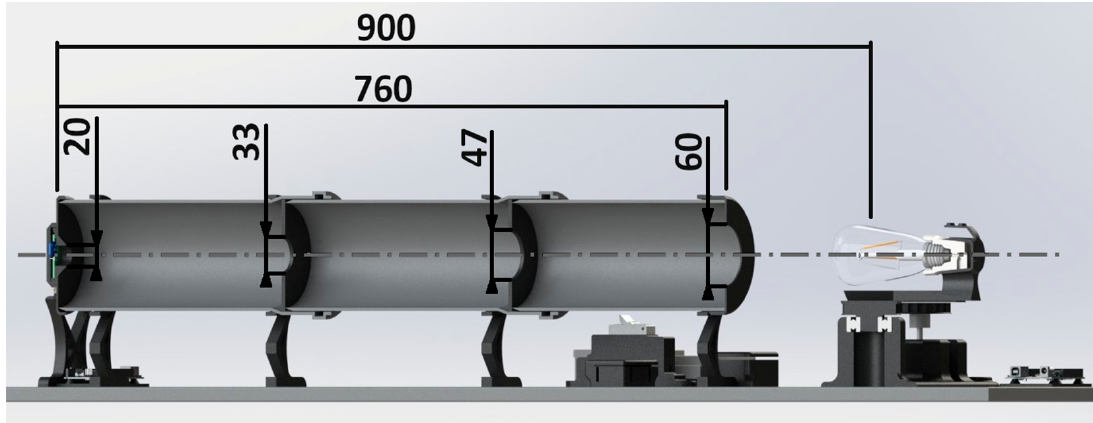
Figure 5. Cross-section view of the measuring system with dimensions [mm].